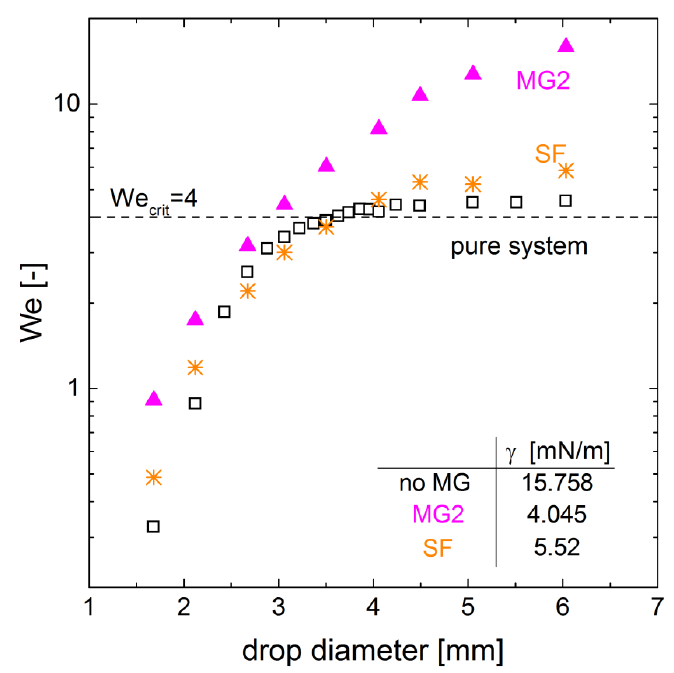
Figure 7. Weber number as a function of the drop diameter, for the pure water/ n -butyl acetate system and the system containing MG2 and surfactant, respectively. The critical Weber number We = 4 refers to the onset of deformation [18,21]. The interfacial tensions of the three different systems applied in the Weber number are given in the table (standard deviation below 1.8 × 10 − 2 mN /